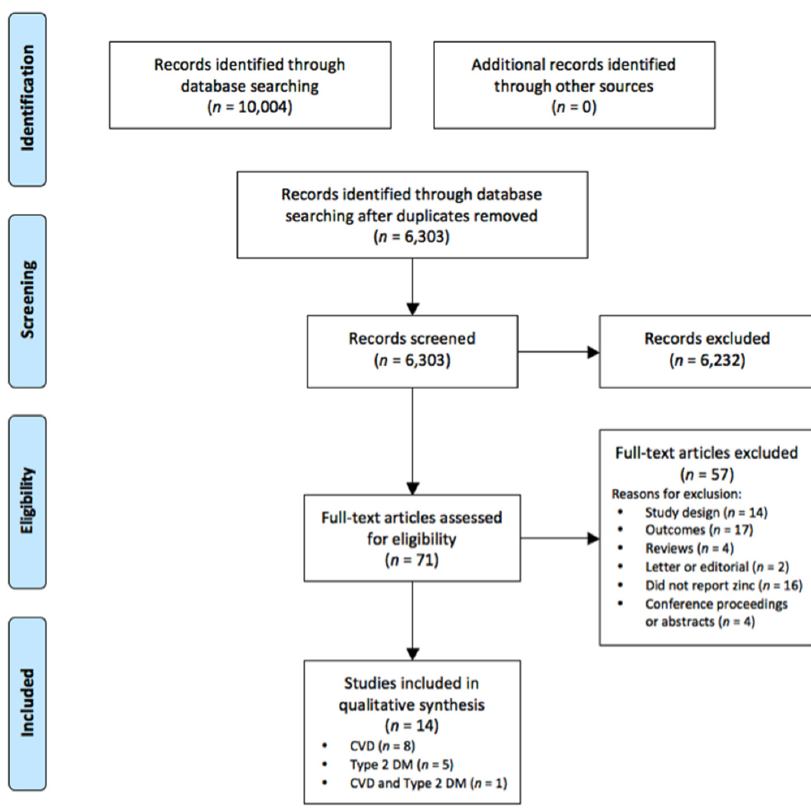
Figure 1. PRISMA diagram showing the systematic review process.